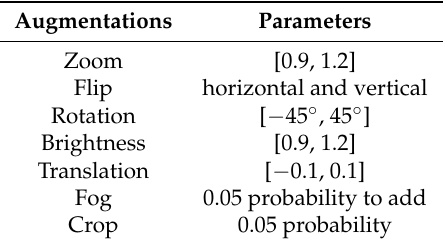
Figure 8. Examples of the annotations that were made over the images. Table 2. Transformations applied to the dataset.